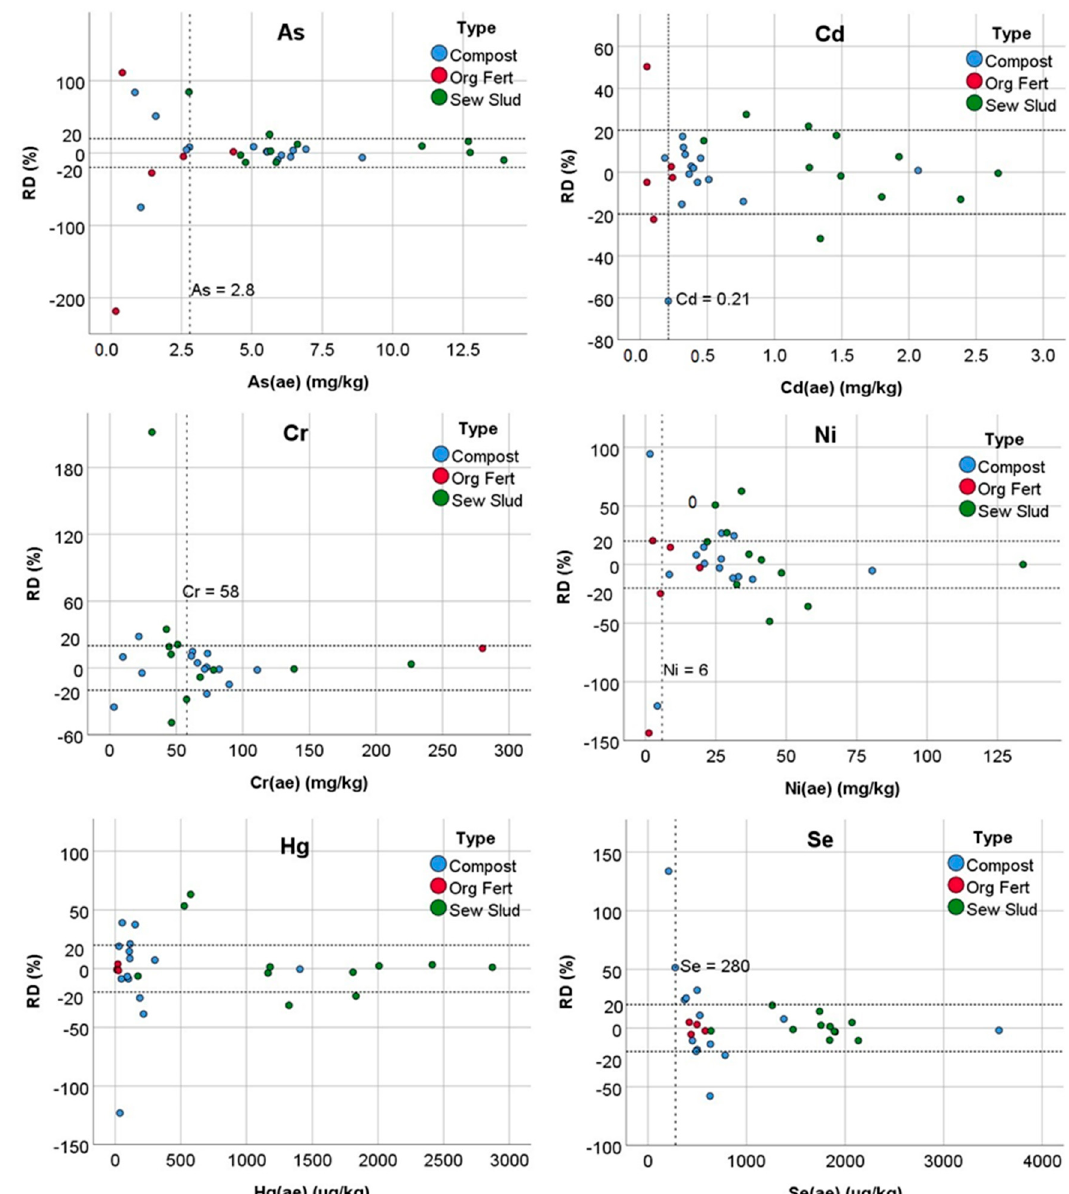
Figure 4. Relative di ff erences (RDs) of the predicted aqua regia concentrations of the target elements.